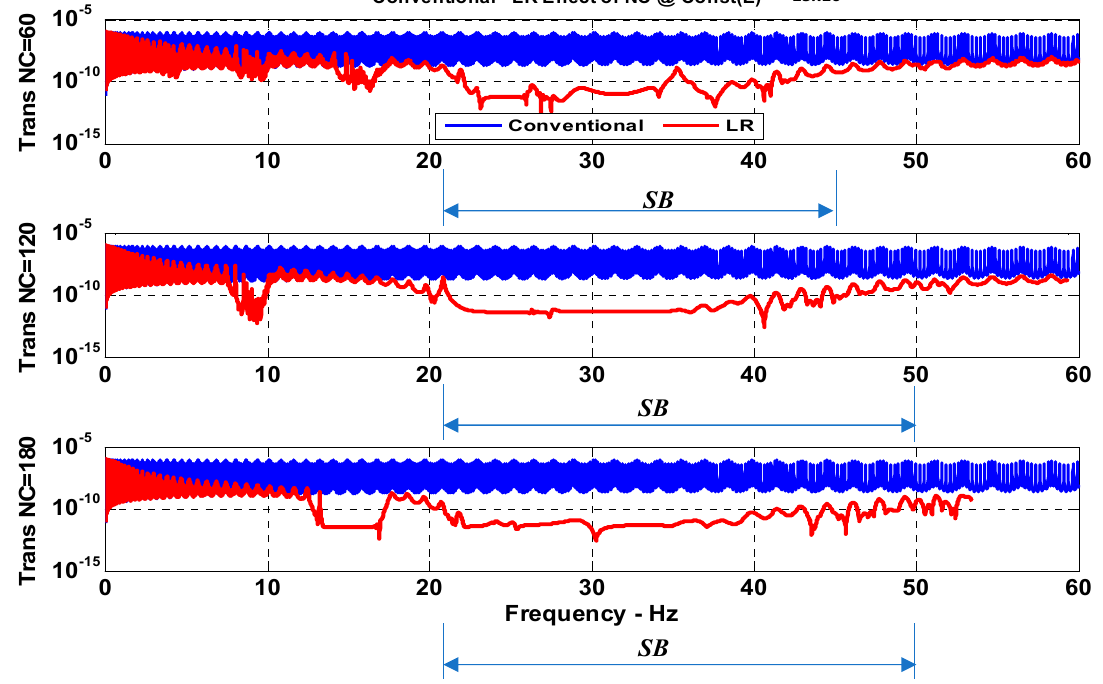
string, with periodic LR inserts for a different number of inserts when the VEM has a constant storage modulus ( SB: Stop band).